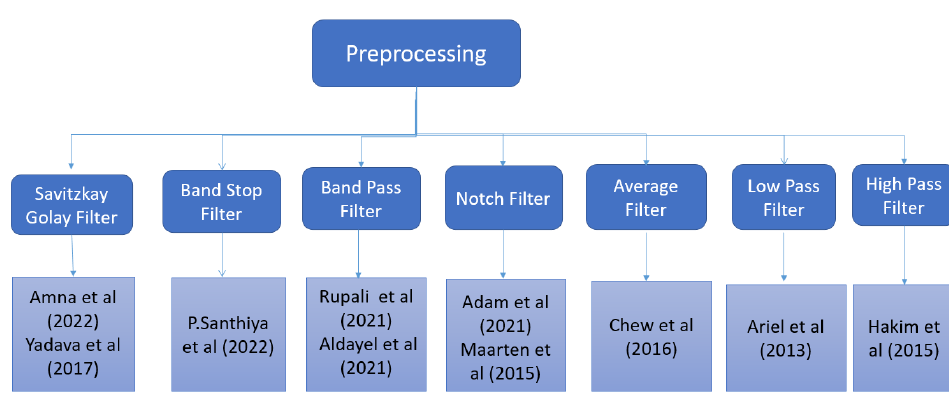
Figure 1. Preprocessing of EEG signals in